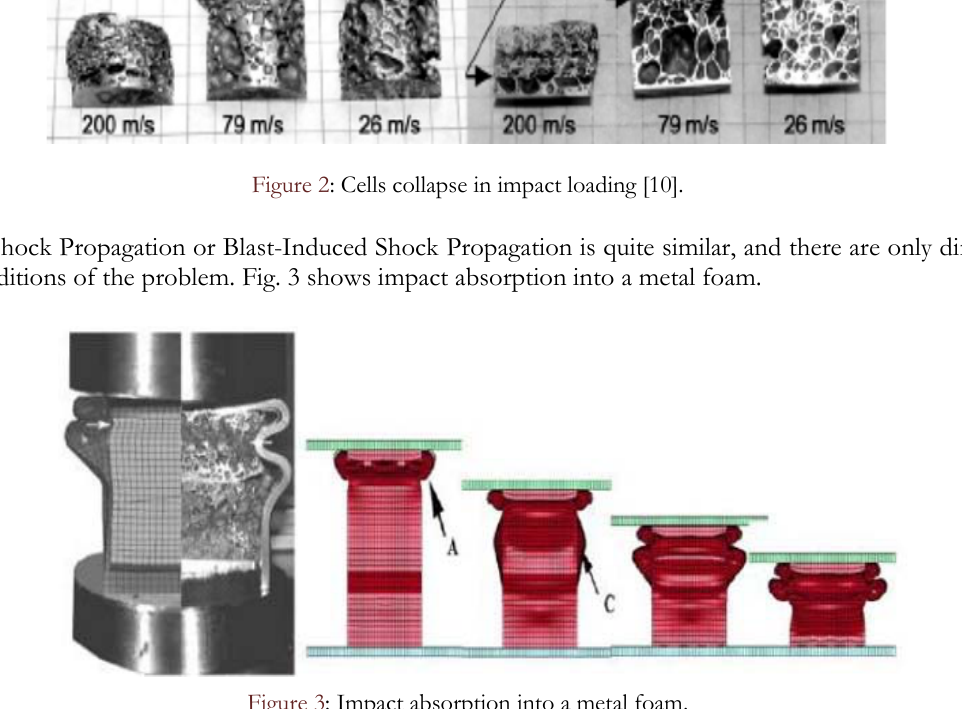
Figure 3: Impact absorption into a metal